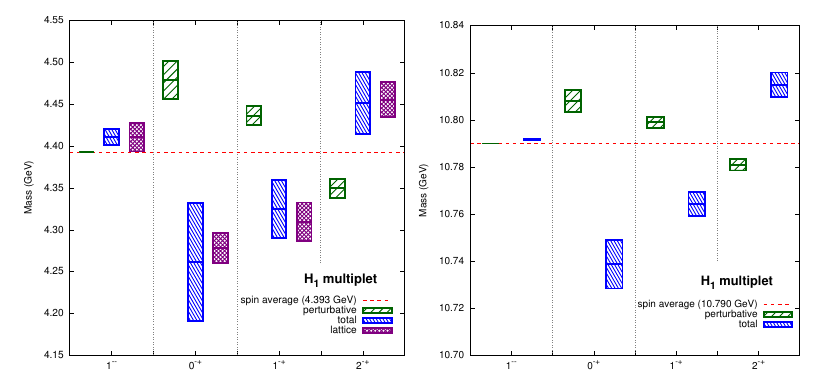
Figure 3. Spectrum of the lowest-lying charmonium (left) and bottomonium (right) hy- brid multiplet. The lattice results for the charmonium sector from Ref. [26] are the most right (purple) boxes for each quantum number. The perturbative contributions to the spin- dependent operators in Eq. (10) added to the spin average of the lattice results (red dashed lines) are the most left (green) boxes. The central (blue) boxes for each quantum number are the full results from the spin-dependent operators of Eqs. (9) and (10) including perturbative and nonperturbative contributions. The height of the boxes indicates the